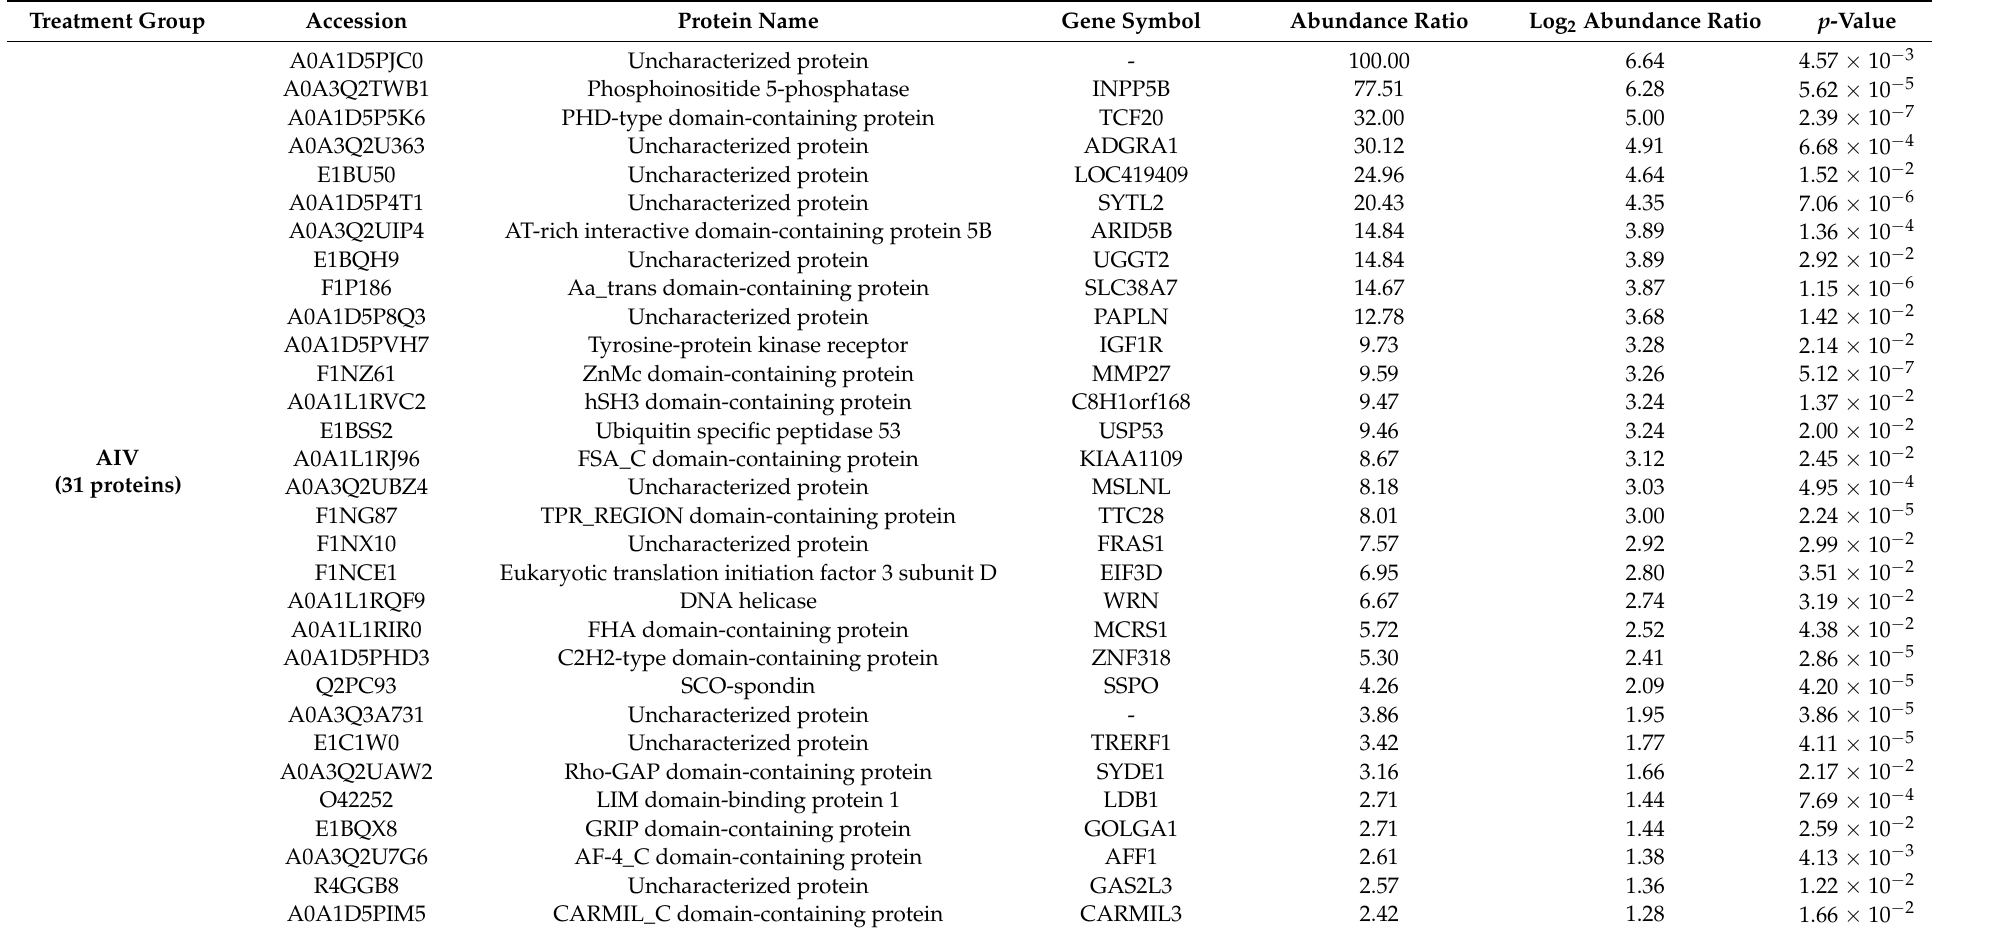
Table 2. Up-regulated proteins of EVs from TOCs treated with AIV, LPS, and polyI:C. Following differential expression filtering (abundance ratio ≥ 2-fold change and p -value < 0.05), 31, 31, and 24 proteins were found to be up-regulated in the AIV, LPS, and polyI:C treatment groups,